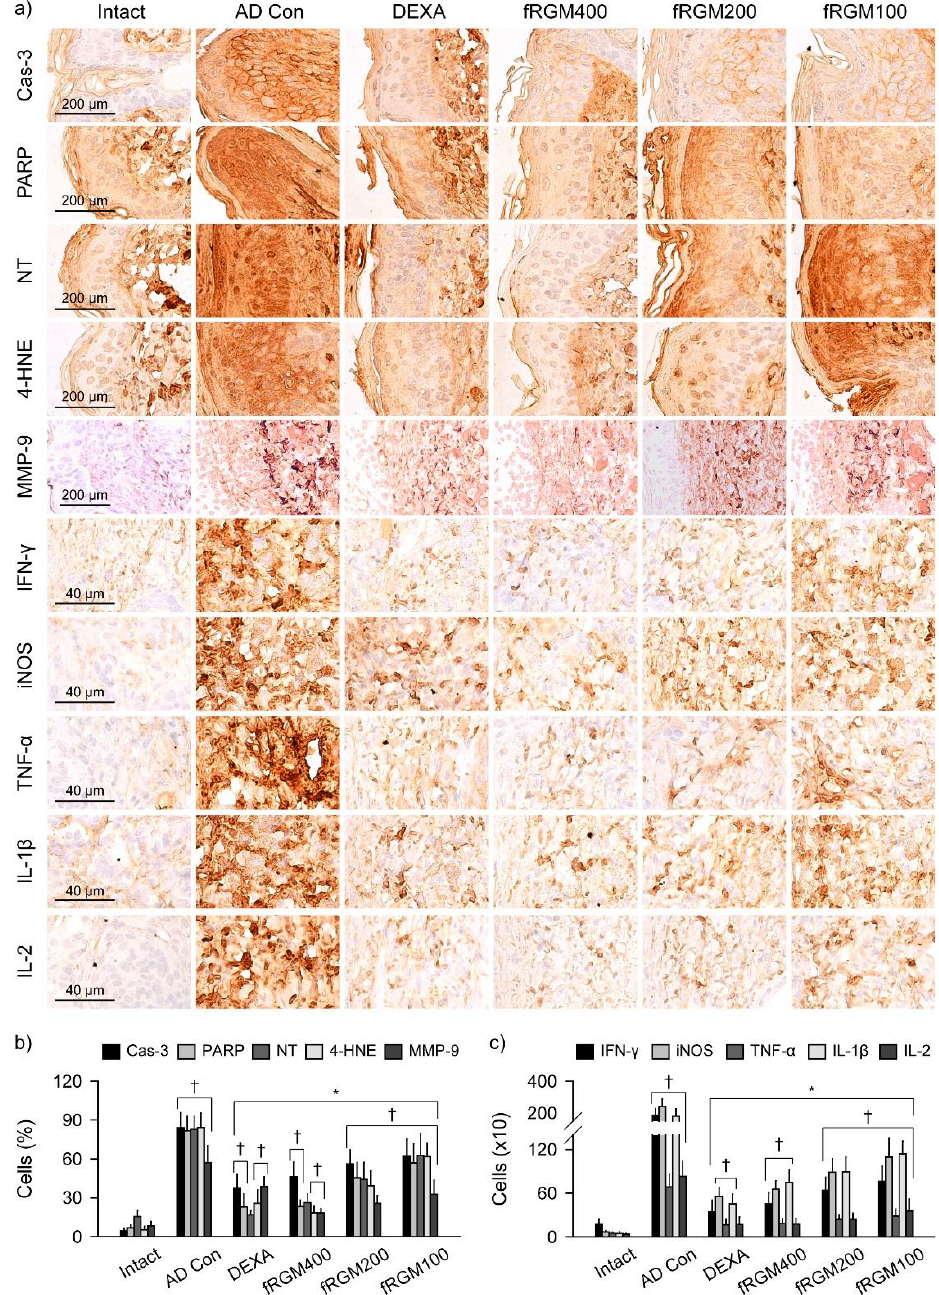
Figure 5. Immunohistochemistry in AD-like skin lesions. ( a ) Representative images in immunostains for cleaved caspase-3 (Cas-3), cleaved poly(ADP-ribose) polymerase (PARP), nitrotyrosine (NT), 4-hydroxynonenal (4-HNE), matrix metalloprotease (MMP)-9, interferon (IFN)- γ, inducible nitric oxide synthase-2 (iNOS), TNF- α , IL-1 β , and IL-2. ( b , c ) The immunoreactive cells in the dermis (% in 100 cells or ×10 cells/mm 2 ). Values are represented as means ± SDs. †: p < 0.05 vs. the Intact group; *: p < 0.05 vs. AD Con.